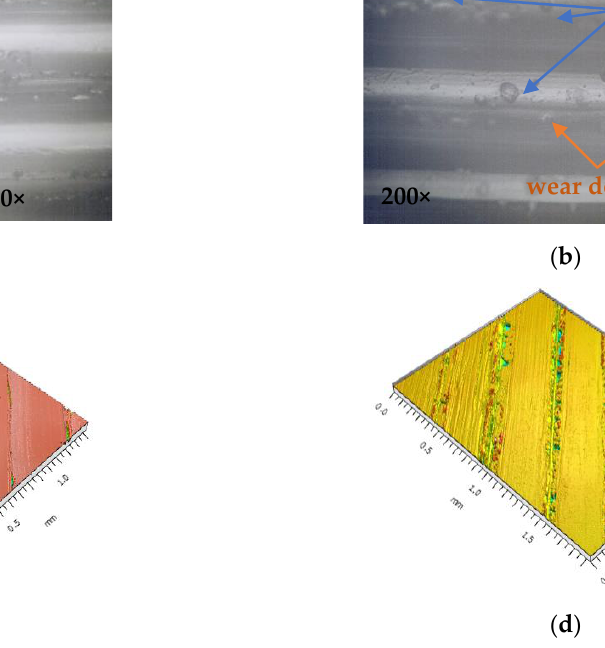
Figure 21. Charpy test specimens.